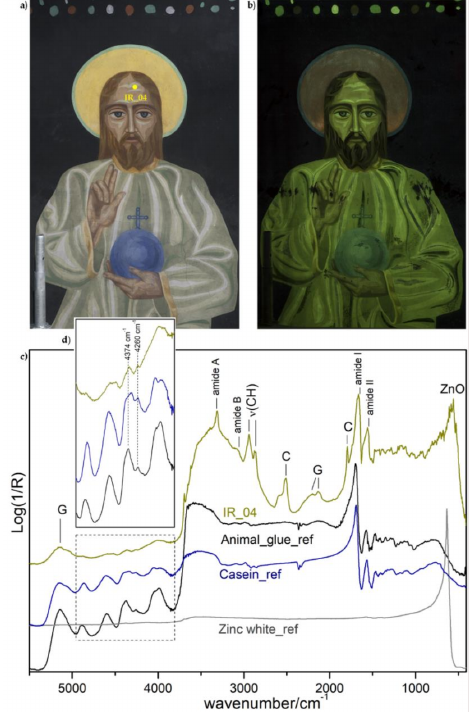
Figure 3. ( a ) Vis and ( b ) UVL images of the central figure (image size ca. 90 cm × 90 cm) of the Trinity shown in Figure 2b. The UV-induced visible luminescence in ( b ) is related to the presence of zinc white (ZnO) and cadmium-based pigments (Cd in the halo). ( c ) Reflection FT-IR spectrum collected from the point IR_04 (location shown in ( a ) in comparison with reference spectra of animal glue, casein and zinc white. Marker bands of calcium carbonate (C) and gypsum (G). ( d ) Magnification of the spectral range between ca. 3750 and 5000 cm − 1 showing better match with the FT-IR spectrum of animal glue than with that of